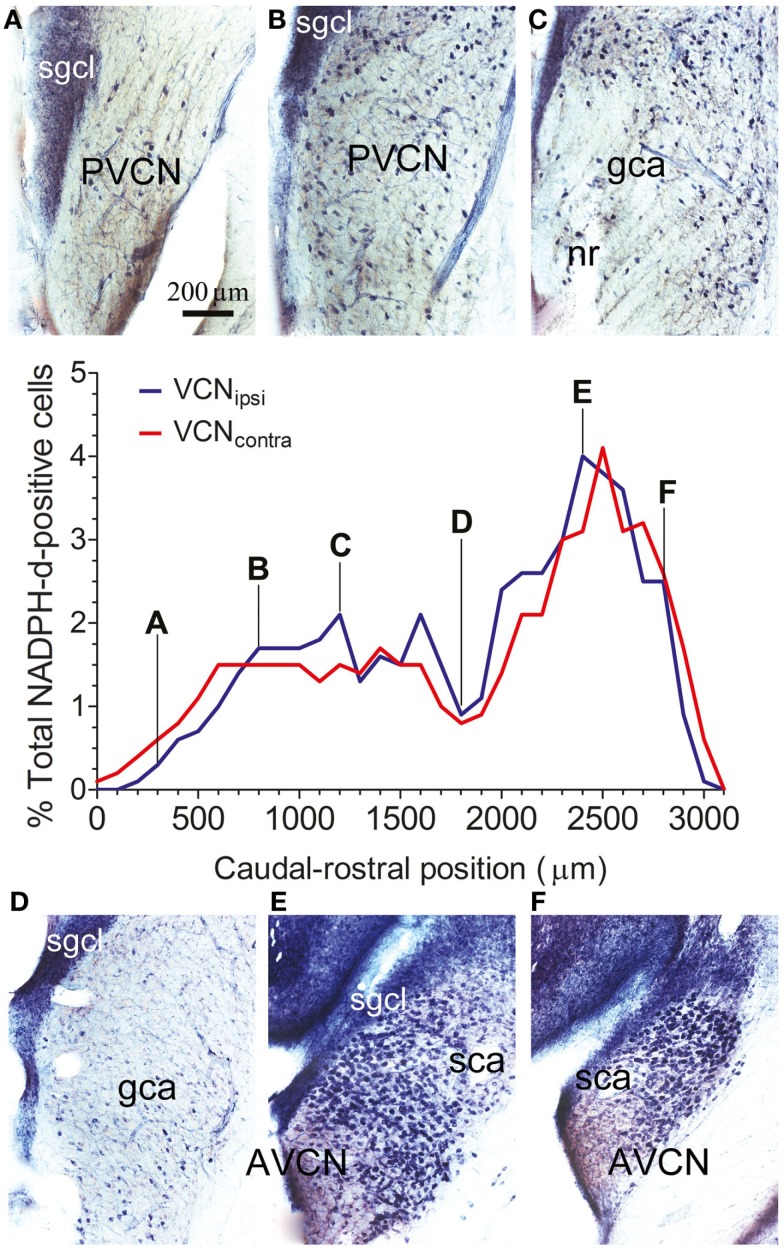
The spatial distribution of NOS in the VCN. The percentage of NADPH-d-positive neurons from the total population of counted NADPH-d-positive cells is shown according to position on the caudal–rostral axis of the VCN in a single control GP. Data are shown for VCNipsi (blue) and VCNcontra (red). Photographs show staining patterns in coronal sections at progressive points along the caudal–rostral axis of the VCN, from PVCN through to AVCN at (A) 300 μm, (B) 800 μm, (C) 1200 μm, (D) 1800 μm, (E) 2400 μm, and (F) 2800 μm, relative to the caudal pole of PVCN. Also indicated on the images are the locations of the small granule cell layer (SGCL), globular (bushy) cell area (GCA), and spherical (bushy) cell area (SCA), as per the scheme of Hackney et al. (27).